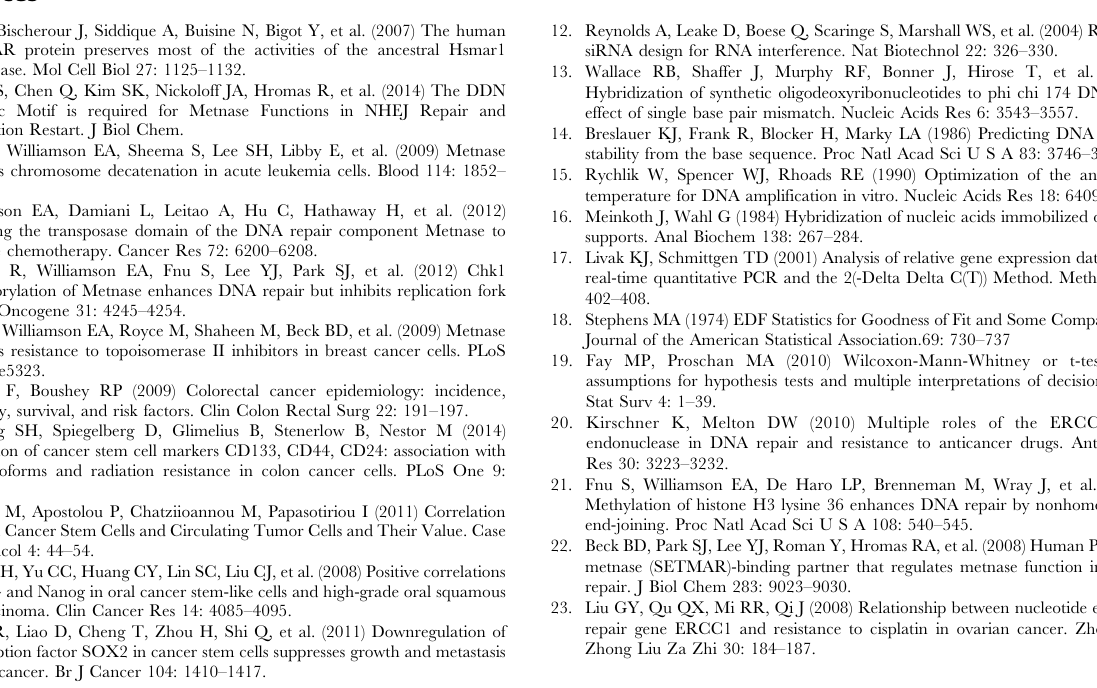
Figure S1 Standard Curves – Standard curves for all